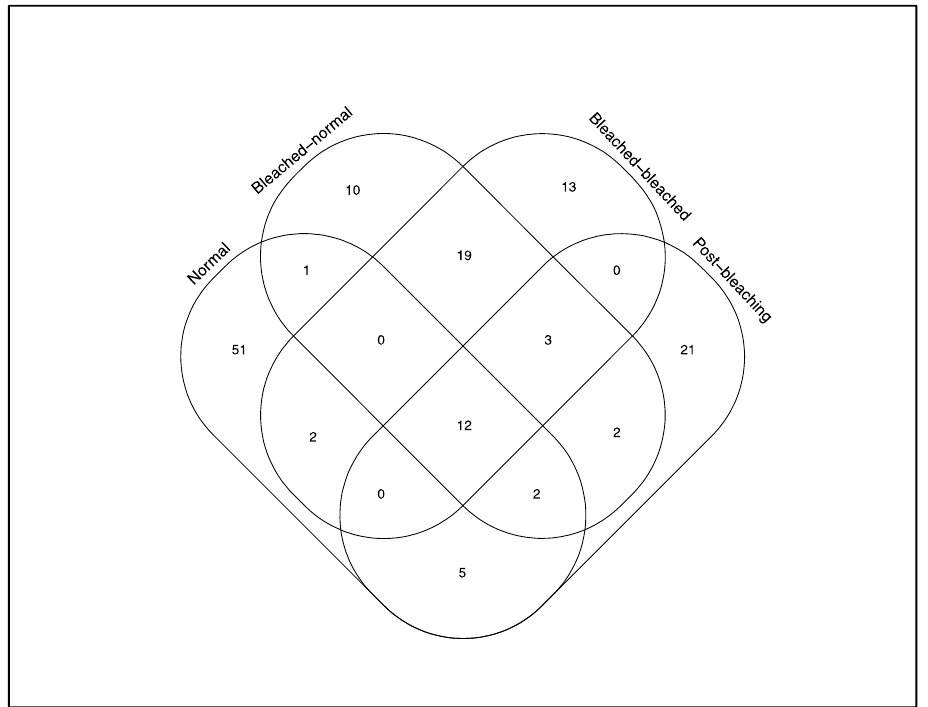
Figure 5. Venn diagram of shared and unique Symbiodiniaceae types among the five different coral groups. Post-bleaching corals include those from 2017 and 2018.